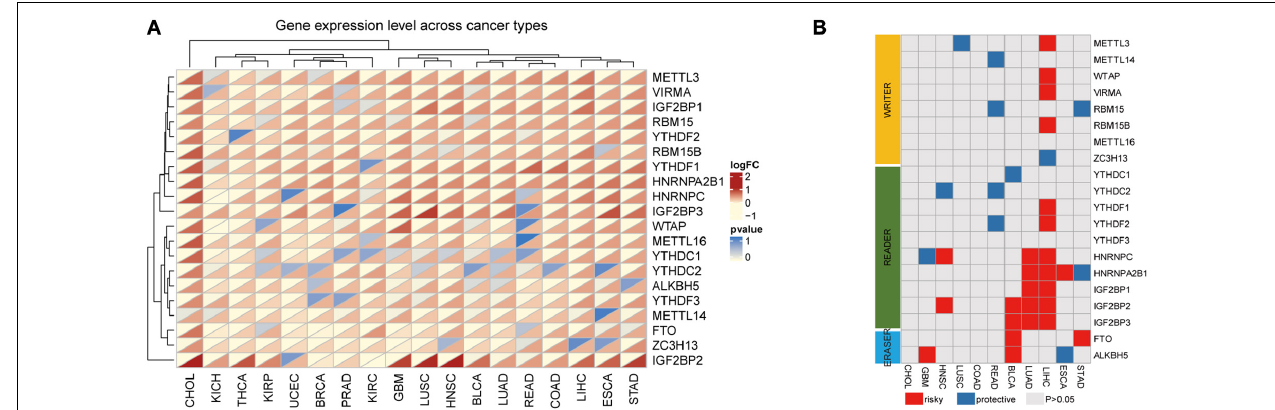
FIGURE 1 | The expression of m6A-related genes in the pan-cancer analysis. (A) Gene expression variation of m6A genes across 18 cancer types. The heatmap shows the fold changes. Red represents overexpression genes and yellow represents lower expression genes. P < 0.05 was considered as statistically significant. (B) The relationship between higher expression of m6A-associated genes and patient survival, with red and blue representing worse and better survival, respectively. Only P -values < 0.05 are shown.